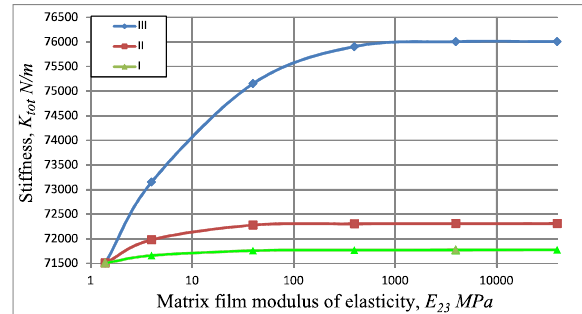
Fig. 6. Variation of the film modulus of elasticity at different thicknesses δ : I as δ = 4 µm; II as δ = 12 µ m, and III as δ = 50 µ m